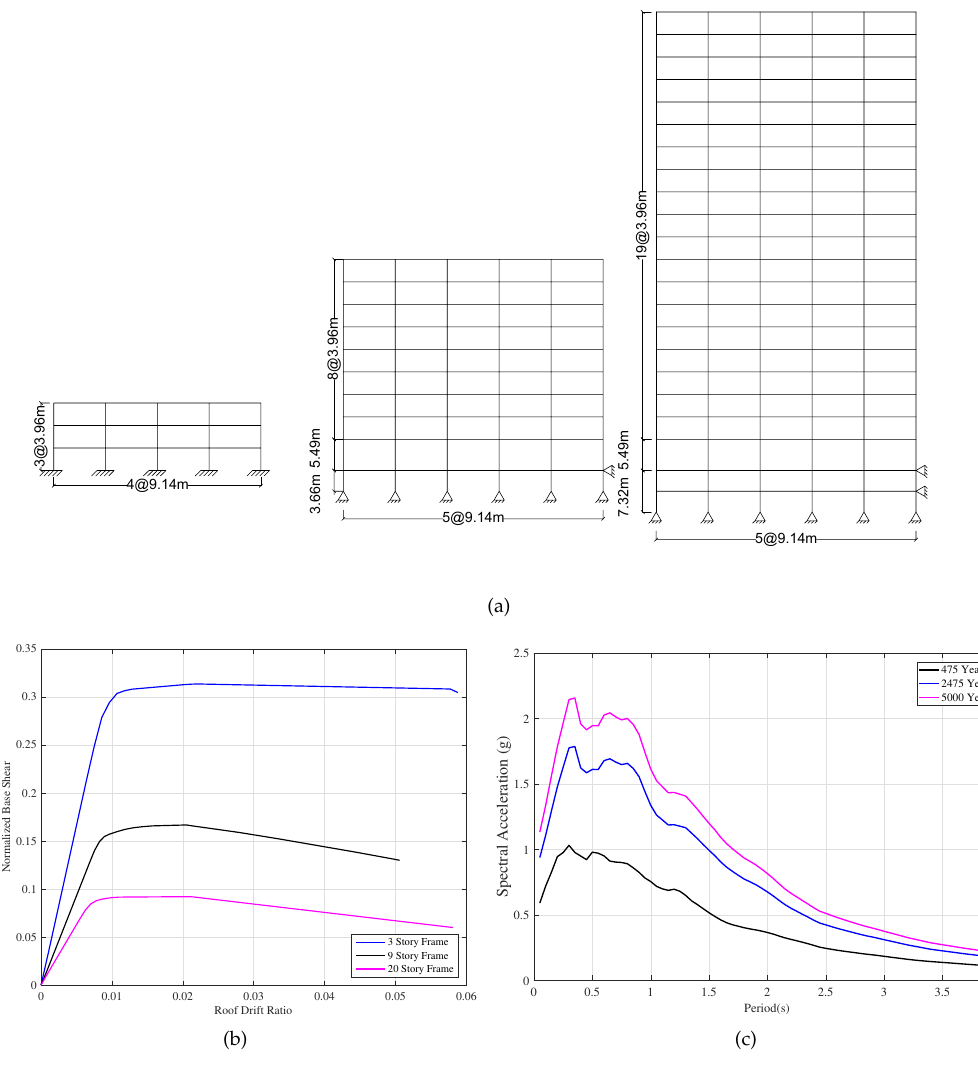
Figure 2. ( a ) Elevation view of the buildings ( b ) the capacity curves obtained from nonlinear static analysis ( c ) median response spectra for the ground motion sets.